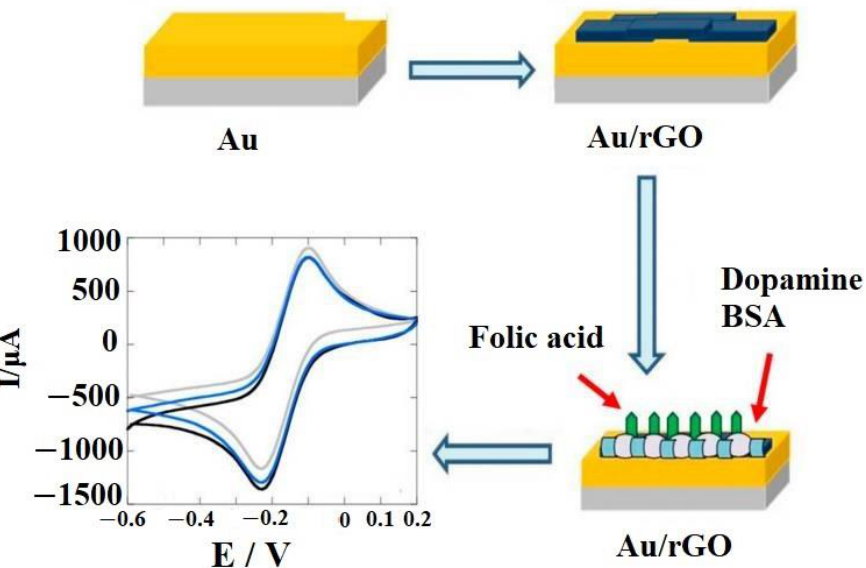
Figure 14. Electrochemical biosensor using a graphene-modified electrode for quantitative detection of folic acid protein. Reproduced with permission from [181]. Copyright 2016 Elsevier